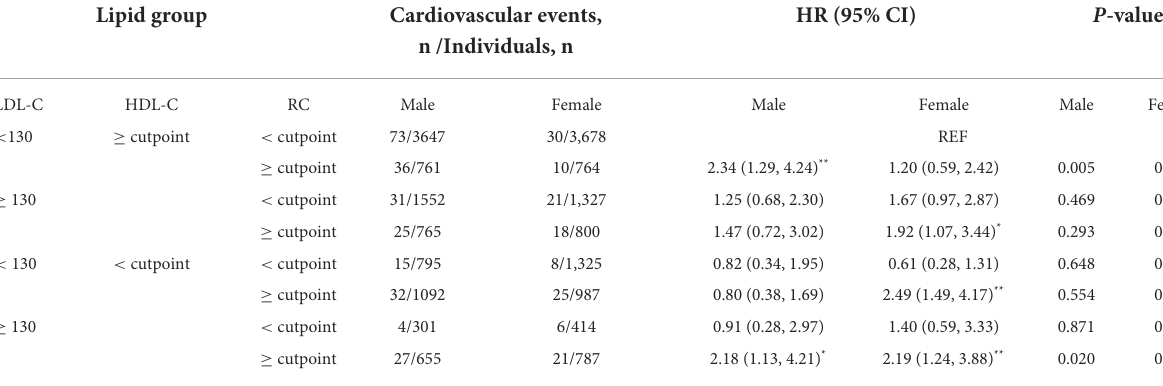
TABLE 5 Hazard ratios (95% confidence interval) and P -value for cardiovascular events of different lipid groups. Lipid group Cardiovascular